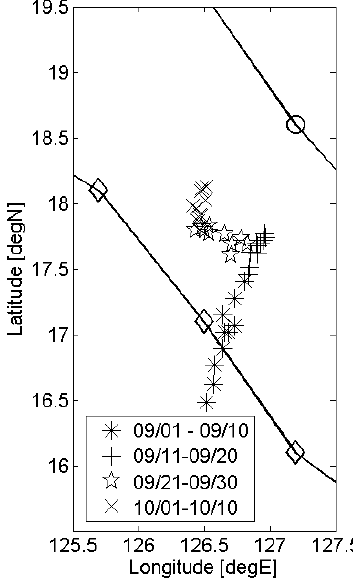
Figure 5. Position of the Argo float ID 5901579 between 1 Septem- ber and 10 October with respect to the typhoon Hagupit (diamonds) and Jangmi (circles) best tracks. The various symbols represent different group time periods as denoted on the plot.